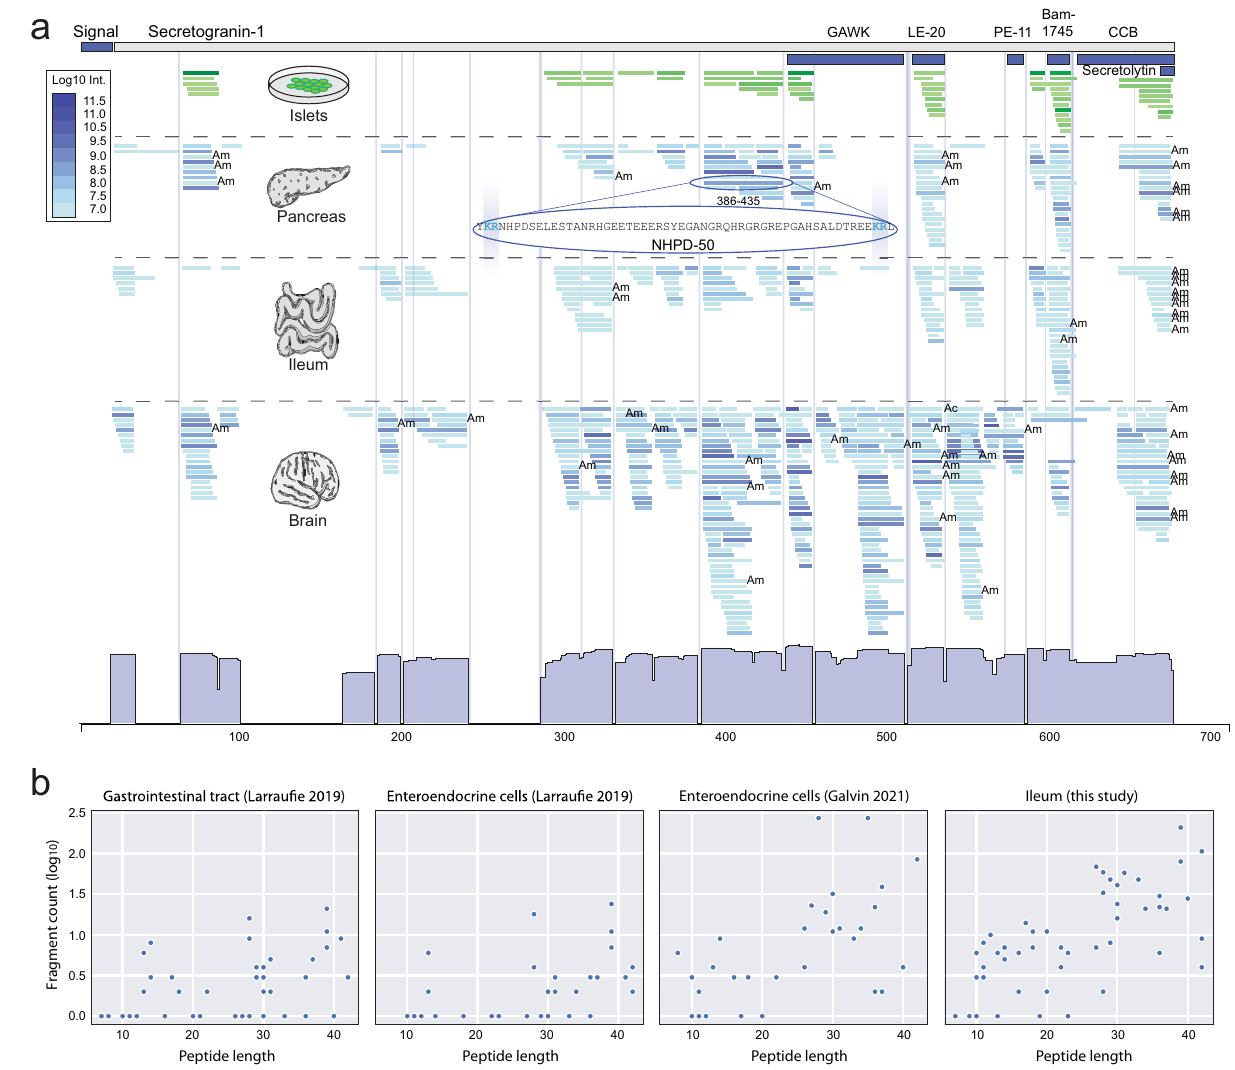
Fig. 3 | Sensitivity and degradation in peptidomics data. a The secretogranin-1 protein (Uniprot ID: P16014) shown in grey and previously identi fi ed peptides (GAWK, LE-20, PE-11, Bam-1745, CCB) as dark blue boxes. The abundance of the peptides are colour coded green for islets and blue for tissue samples. Abundance histogram shown at the bottom and dibasic motifs depicted by vertical lines. Ac Acetylation, Am Amidation. b Degradation characteristics shown as a dot plot for the set of known annotated peptides (Supplementary Data 3) as a function of